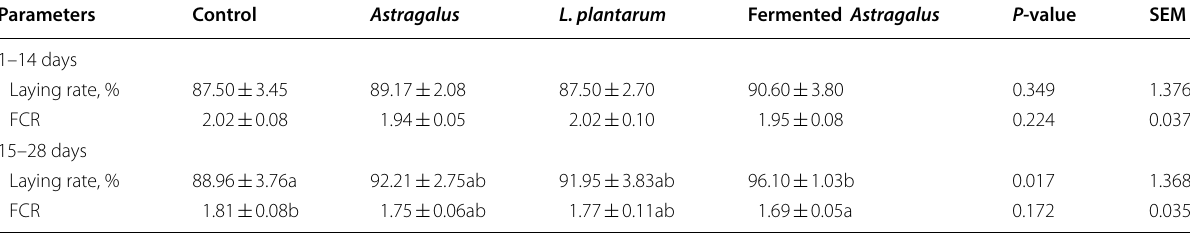
Different lowercase letters in the same row indicate significant difference ( P < 0.05), and the same letters or no letters indicate no significant difference ( P > 0.05) (same as below) FCR feed conversion